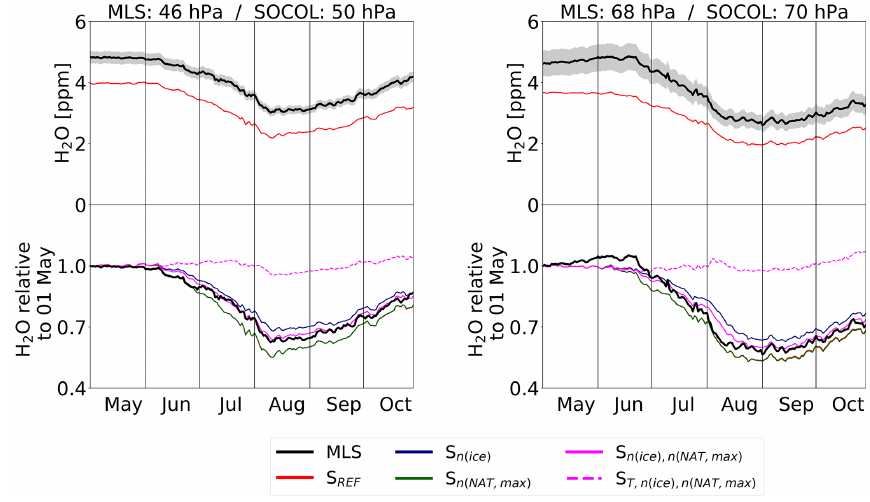
Figure A11. As Fig. 8, but for the year 2006.